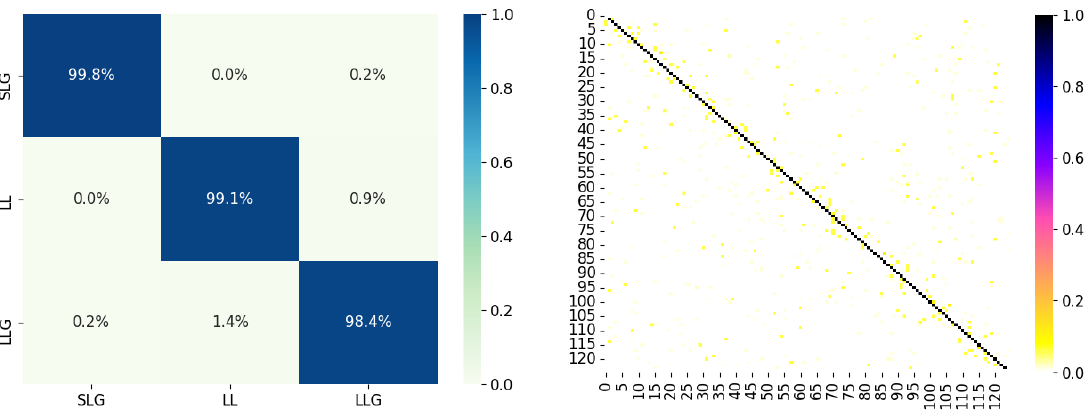
Figure 14. Confusion matrix of performances of fault classification and location in IEEE 123 Bus system.